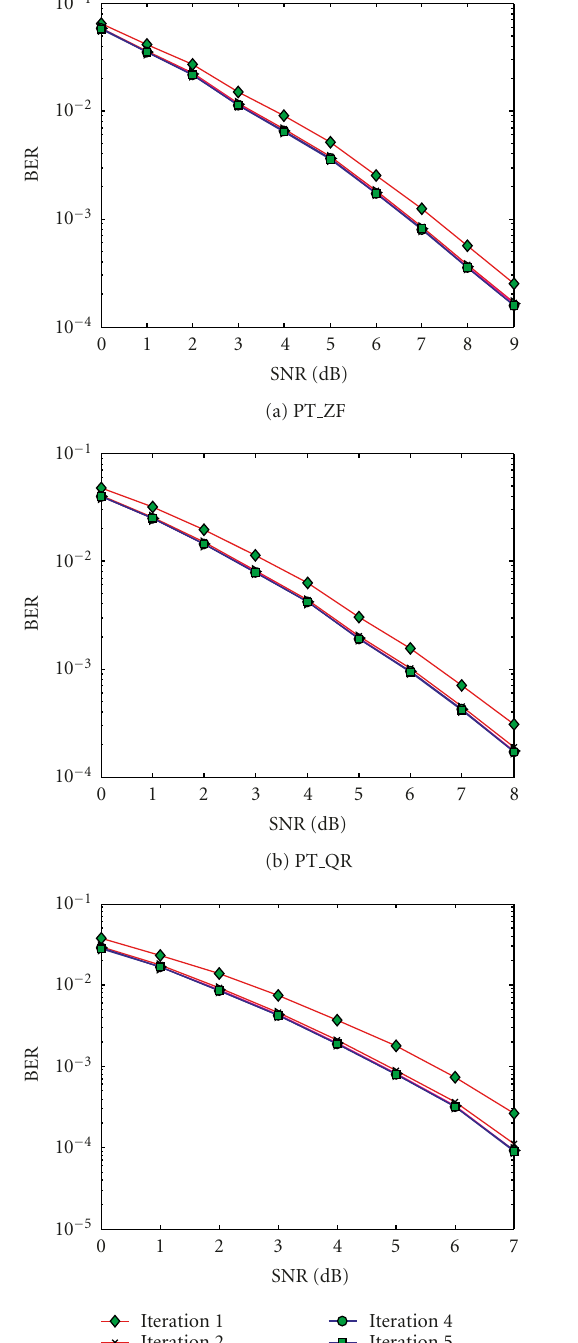
destination. For the scheme in [9], its performance is not improved much, since the cooperation between the relays and the sources are rare (due to unchanged SNR in = SNR + 10 dB as for Figure 7), and as a consequence the better relay-destination channel does not contribute